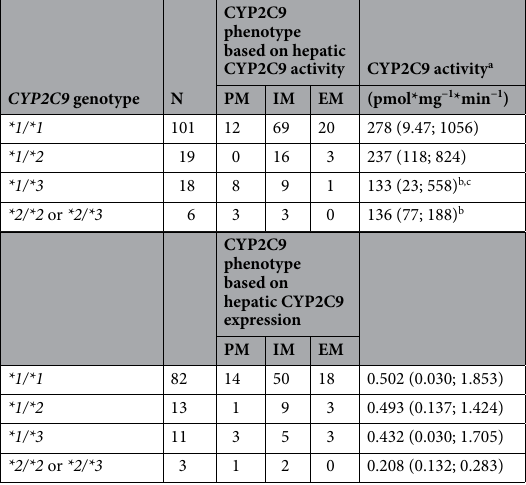
Table 4. Comparison of phenotype predictions based on CYP2C9 genotype and hepatic CYP2C9 activity (N = 144) or CYP2C9 expression (N = 109) in tissue donors. a Median (min, max). b Significant difference